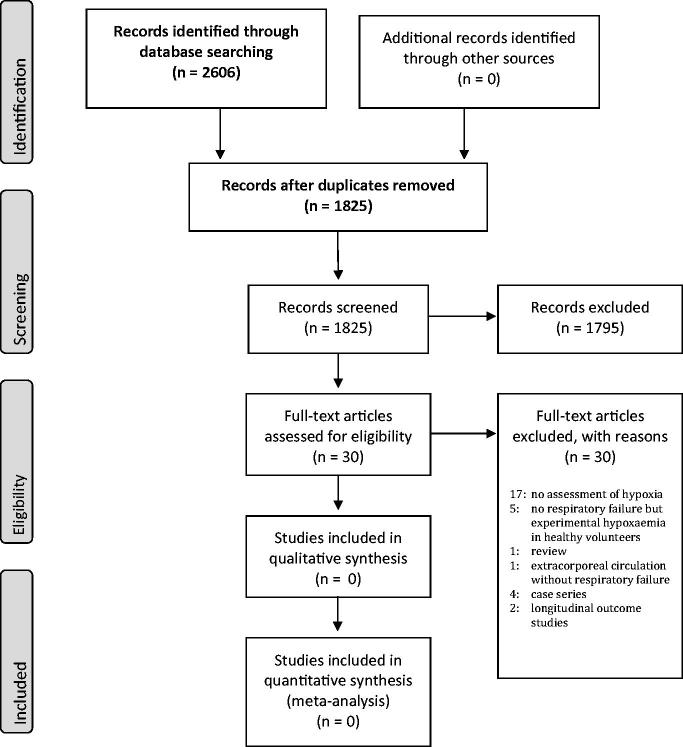
PRISMA 2009 flow diagram.